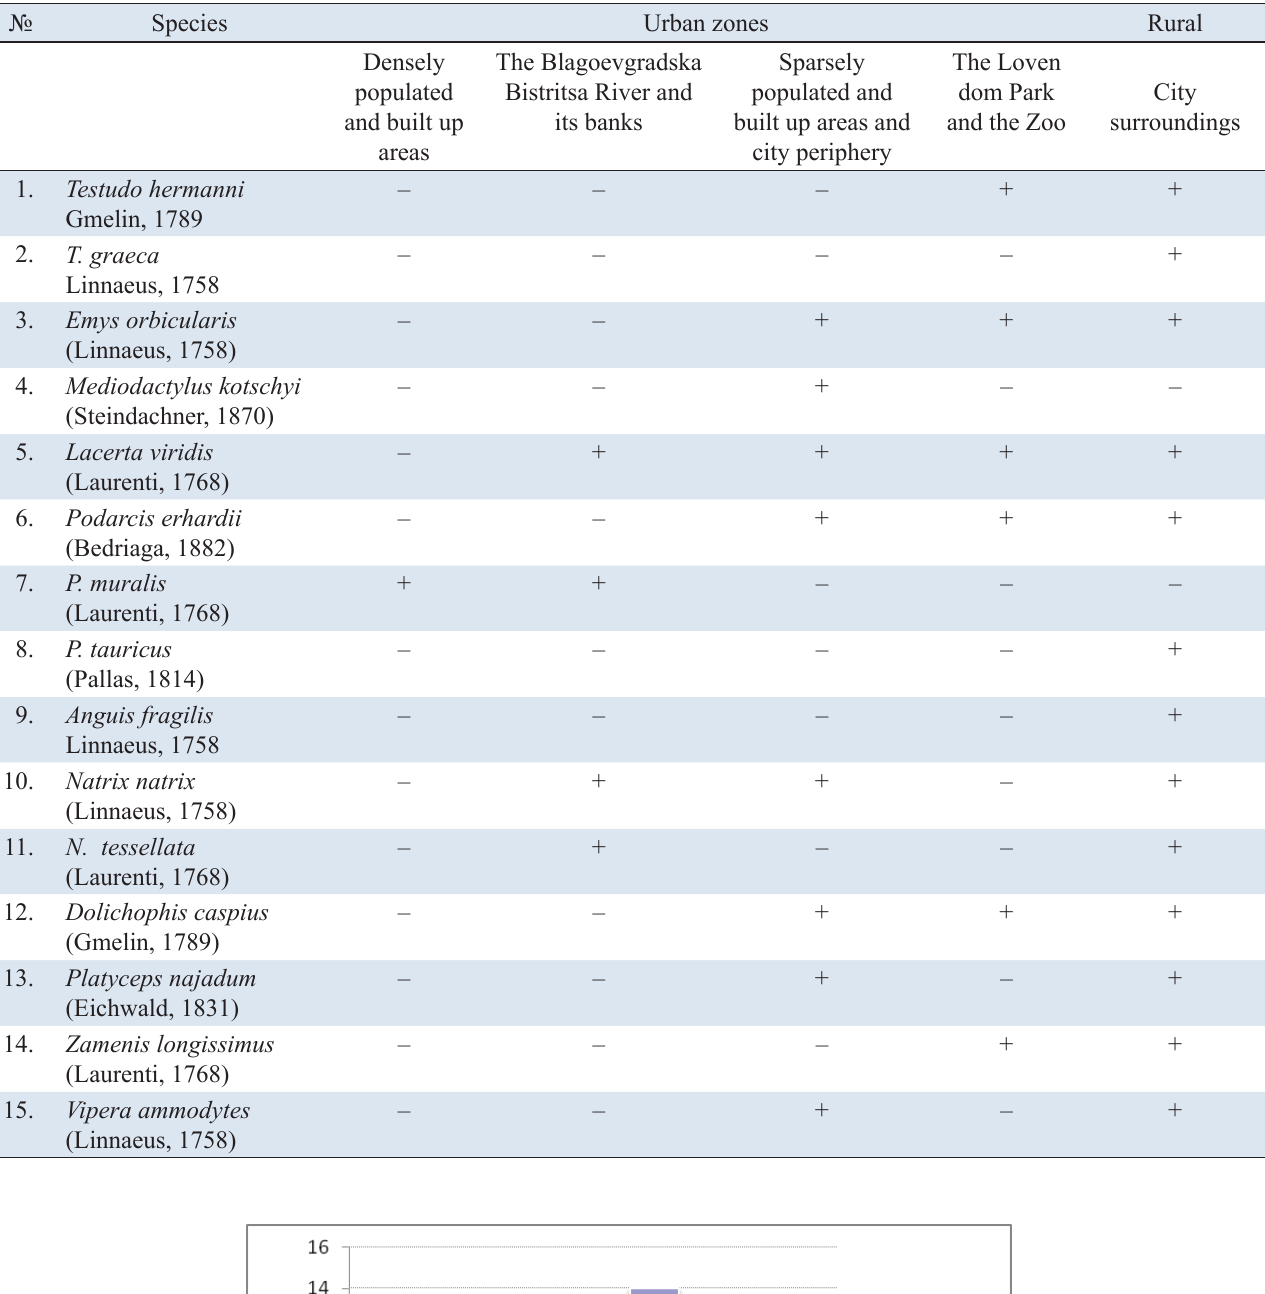
Table 2. Distribution of reptiles in the city of Blagoevgrad and its surroundings. № Species